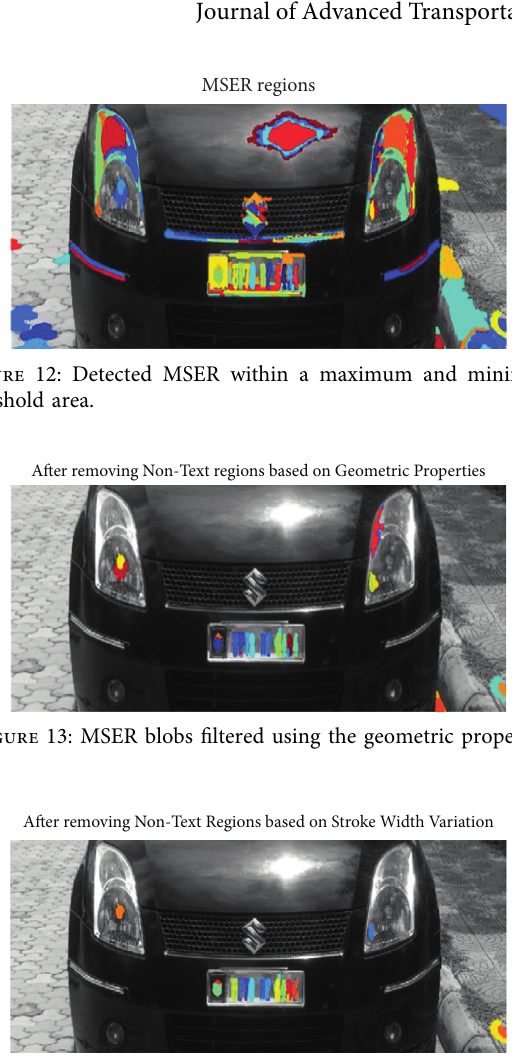
Figure 14: MSER blobs filtered using stroke width variation as a parameter.